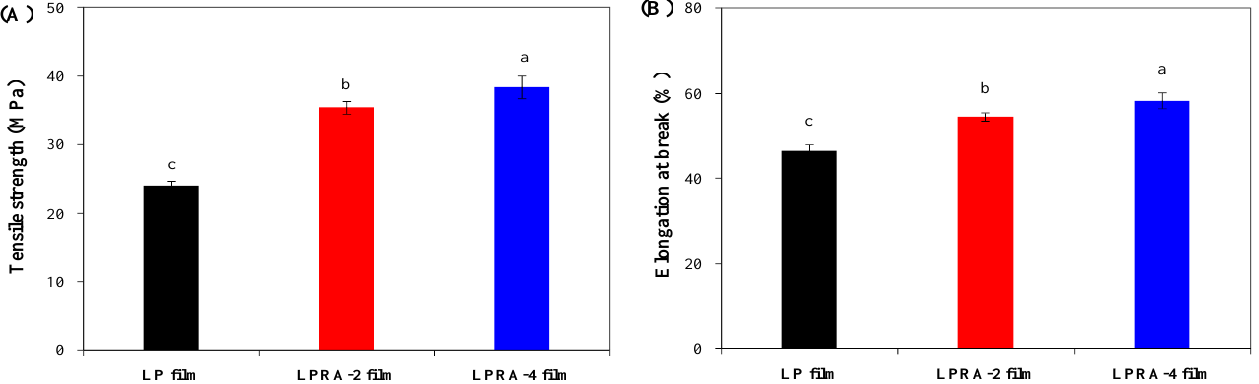
Figure 5. Tensile strength ( A ) and elongation at break ( B ) of LP film, LPRA-2 film, and LPRA-4 film. Values are given as mean ± standard deviation (n = 6 for tensile strength and elongation at break). Different lower case letters indicate the statistically significant difference ( p < 0.05) within different films.